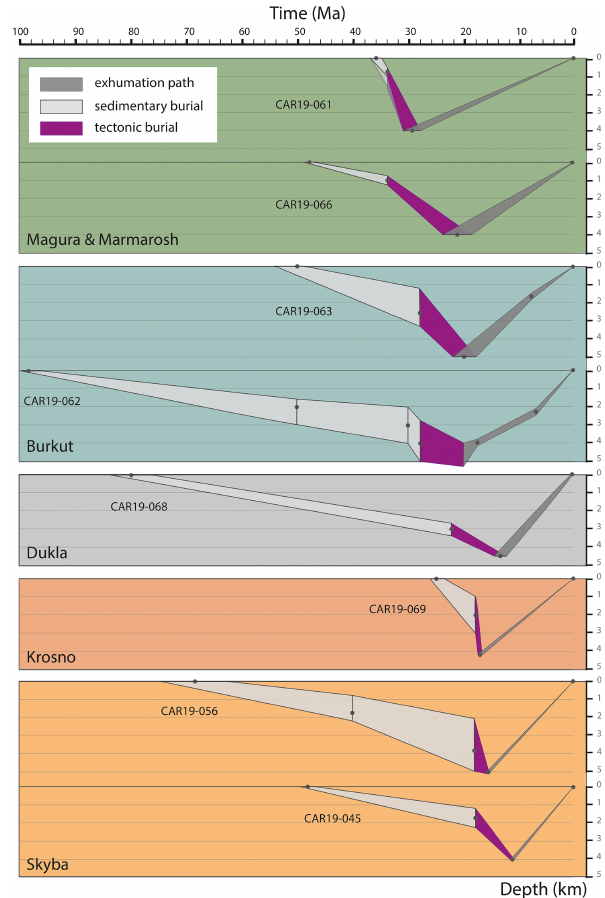
Figure 11. Time–depth evolution of each sample. The depths of the samples through time were estimated from the burial diagrams and the thermal histories modeled in Figs. 7–10 using a geothermal gradient of 25 ◦ Ckm − 1 . Tectonic burial refers to the accretion and burial by thrusting. Time–depth paths are sorted from the innermost (top) to the outermost sample (bottom) of this study. Box colors represent each tectonic nappe as in Fig.